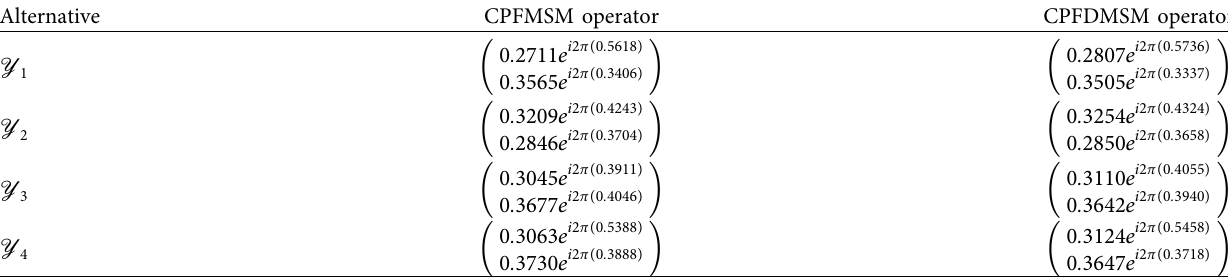
Table 6: Collective evaluation data attained using CPFMSM and CPFDMSM operators.